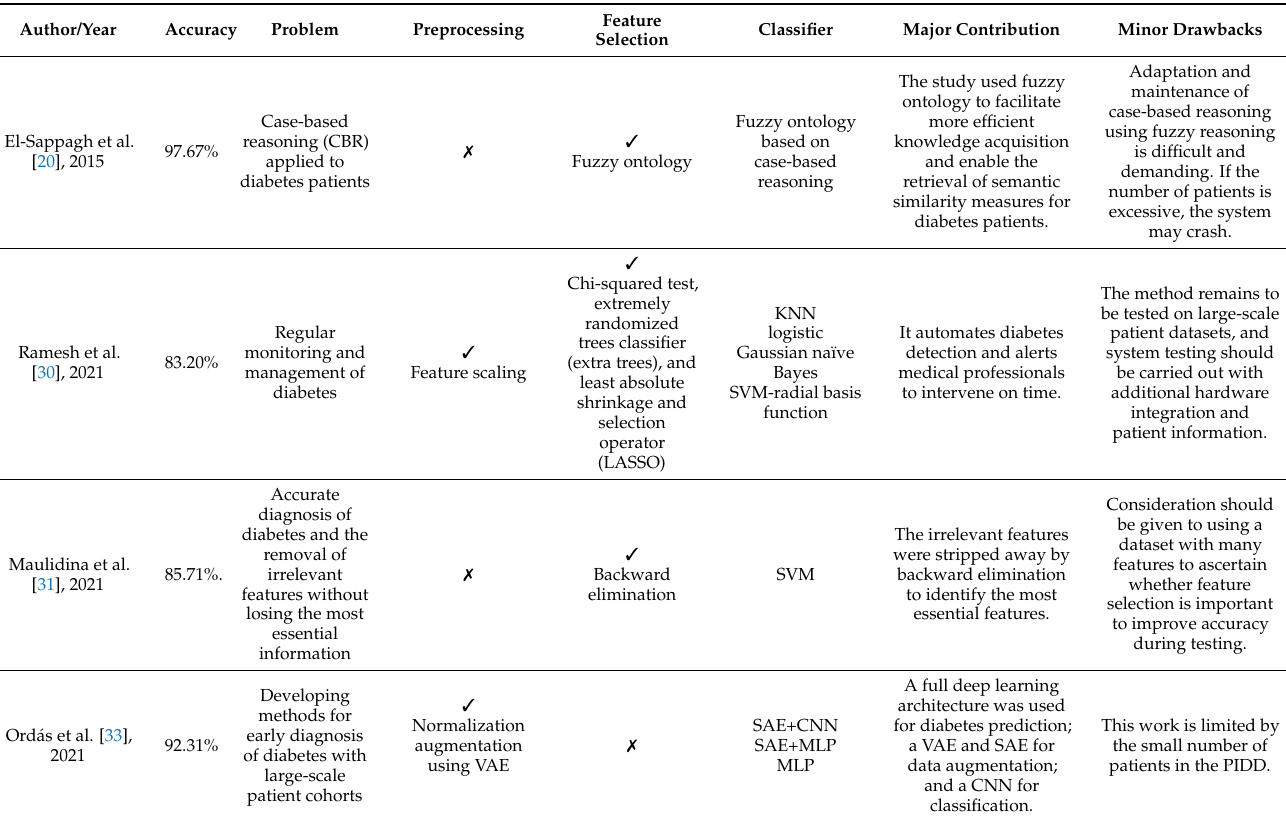
Table 1. The key characteristics of recent diabetes